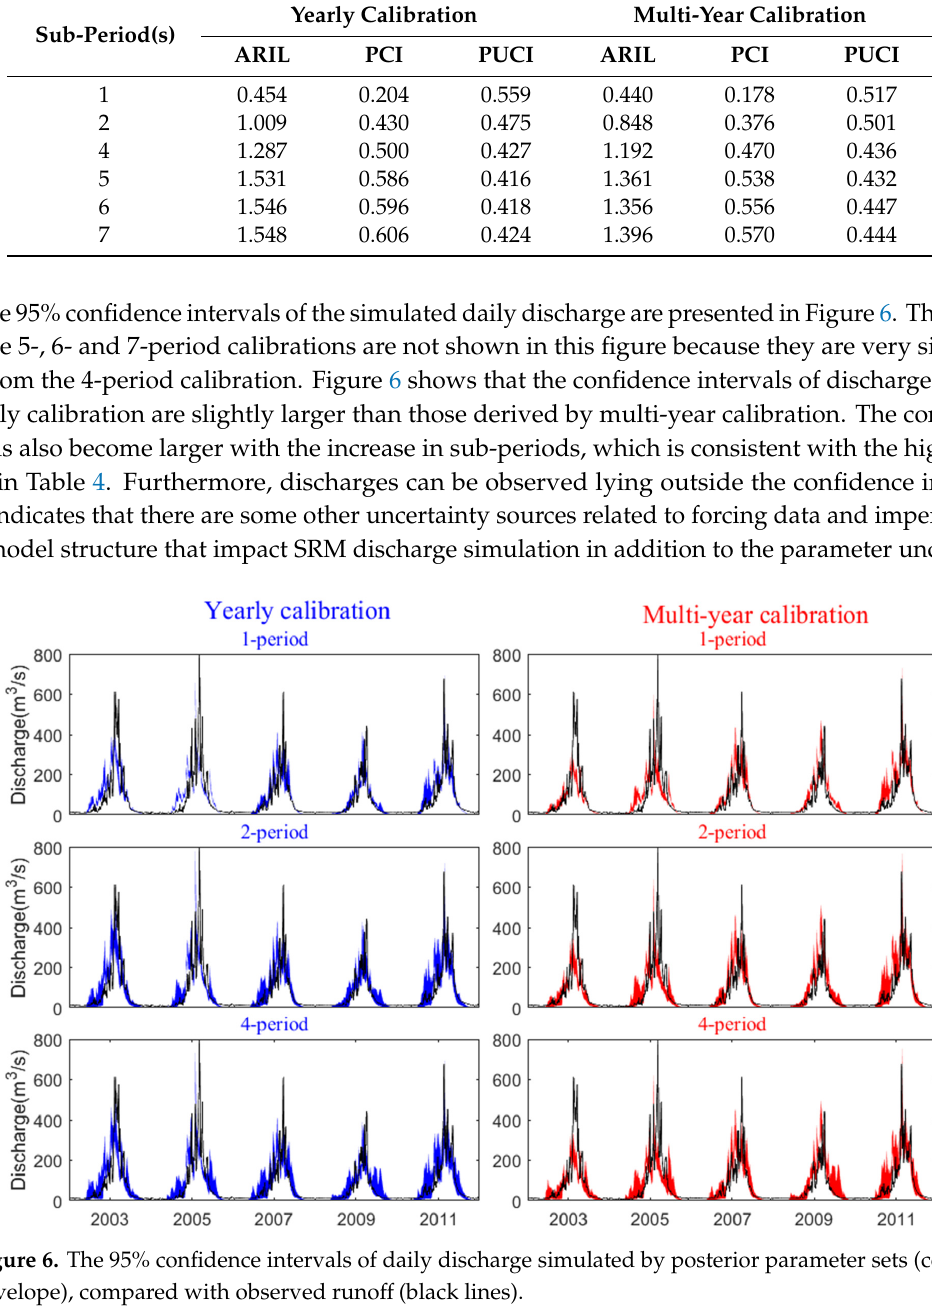
Table 4. The Average Relative Interval Length (ARIL), the percentage of observations bracketed by the Confidence Interval (PCI) and the percentage of observations bracketed by the Unit Confidence Interval (PUCI) values of the different calibration strategies for the 95% confidence interval of discharge by different calibrations.